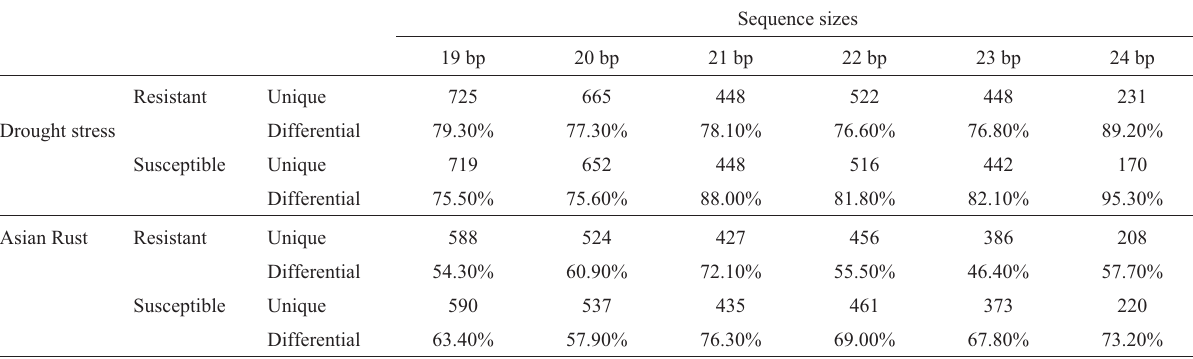
Table 4 - Unique and differential sequences in microRNA libraries generated by the Genosoja